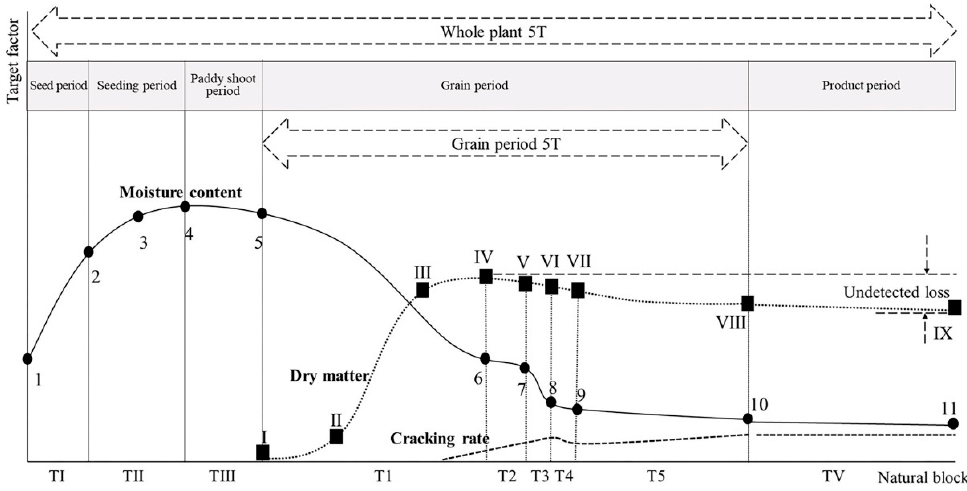
Figure 2. Natural blocks of rice growth and deposit.